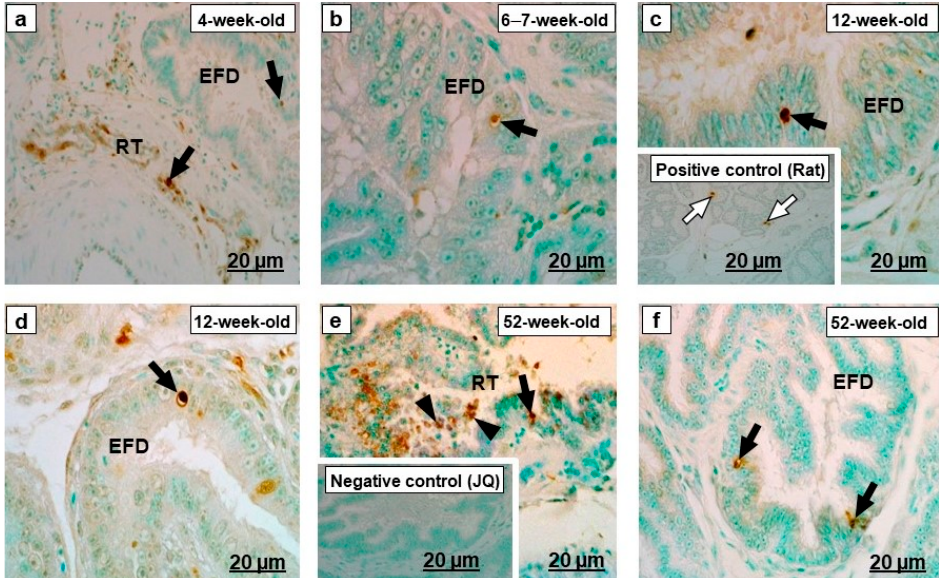
Figure 11. TUNEL-stained sections of the (RT) rete testis and (EFD) efferent ducts of the testicular excurrent duct of Japanese quails ( n = 3 per age group). ( a – f ) Black arrows indicate TUNEL-positive nuclei of epithelial cells in the RT and EFD. Inset ( c ) Positive control: TUNEL-positive cell from the rat mammary gland tissue (white arrowhead). ( e ) Black arrowheads show cellular debris in the RT lumen. ( e ) Inset: Negative control. JQ, Japanese quail.